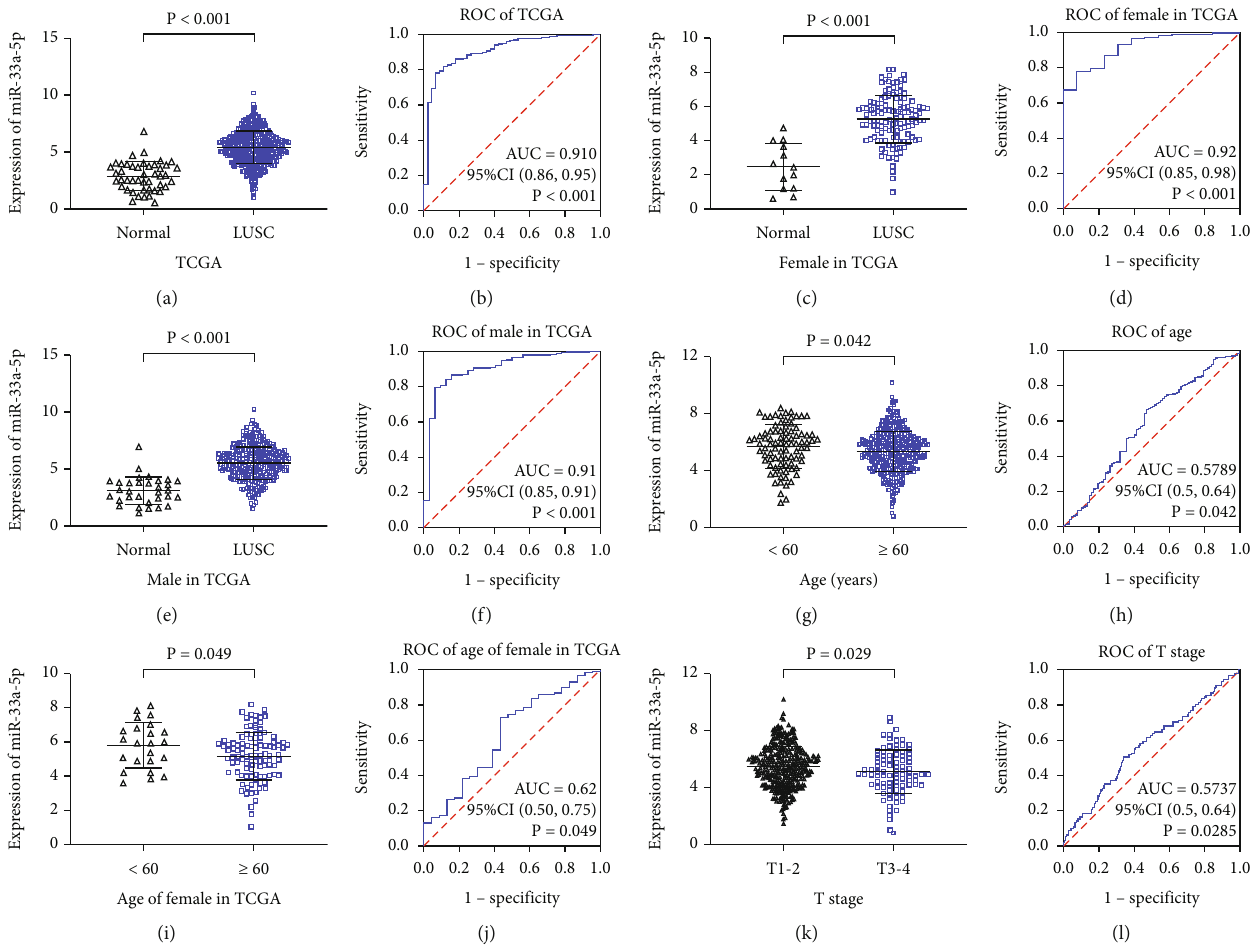
Figure 2: miRNA-33a-5p overexpression in LUSC and its association with clinicopathological parameters based on TCGA. (a) The expression of miRNA-33a-5p in LUSC and nontumor tissues based on TCGA. (b) The ROC curve was generated to assess the diagnostic ability of miRNA-33a-5p in LUSC and noncancerous lung tissues. (c) The expression of miRNA-33a-5p in LUSC and nontumor tissues for female patients based on TCGA. (d) The ROC curve of miRNA-33a-5p expression in female patients based on TCGA. (e) The expression of miRNA-33a-5p in LUSC and nontumor tissues for male patients based on TCGA. (f) The ROC curve of miRNA-33a-5p expression in male patients based on TCGA. (g) The expression of miRNA-33a-5p for age of LUSC patients. (h) The ROC curve of miRNA-33a-5p for age of LUSC. (i) The expression of miRNA-33a-5p in LUSC and nontumor tissues for di ff erent age of female patients based on TCGA. (j) The ROC curve of miRNA-33a-5p expression in di ff erent age of female patients based on TCGA. (k) The expression of miRNA-33a-5p in early (T1 – T2) and late (T3 – T4) T stages of LUSC. (l) The ROC curve of miRNA-33a-5p for T stages of LUSC. AUC: area under the curve; CI: con fi dence interval; LUSC: lung squamous cell carcinoma; ROC: receiver operating characteristic; TCGA: The Cancer Genome